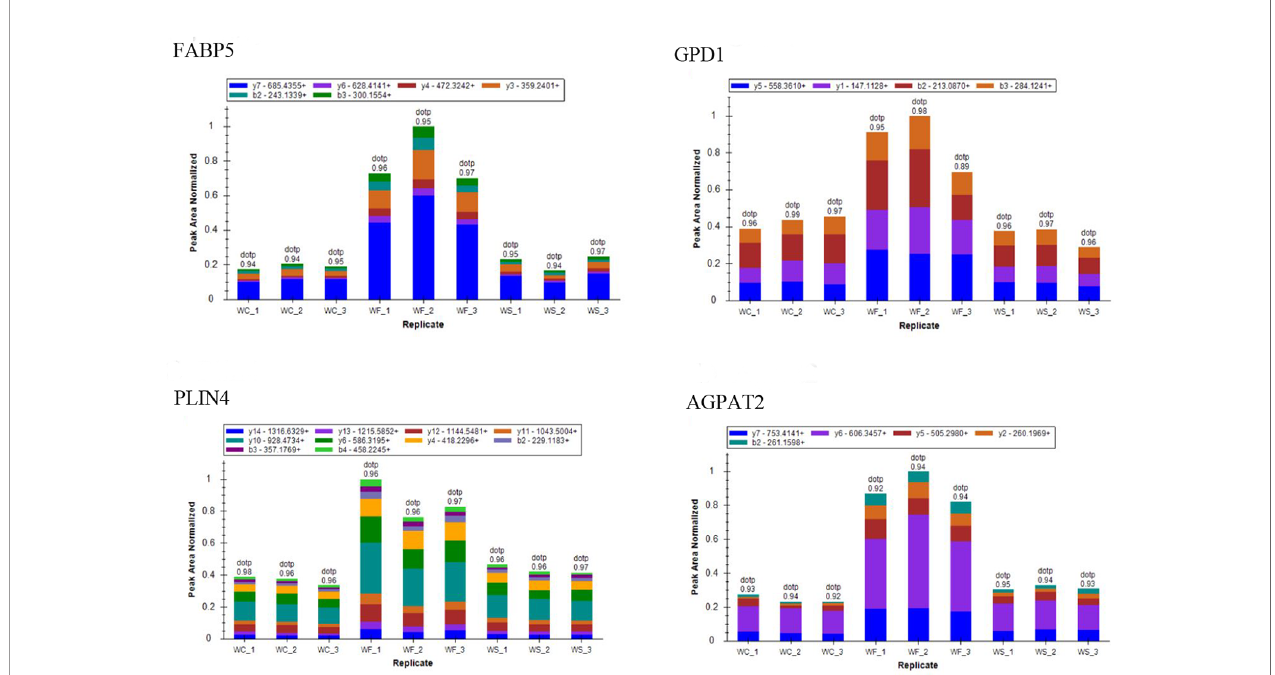
FIGURE 12 | The ion peak area distribution of Fabp5, GPD1, Plin4, and Agpta2 proteins in each sample. After induction of high-fat diet, protein Fabp5, GPD1, Plin4, and Agpta2 increased signi fi cantly. When silibinin was added, all the above proteins in WS group were